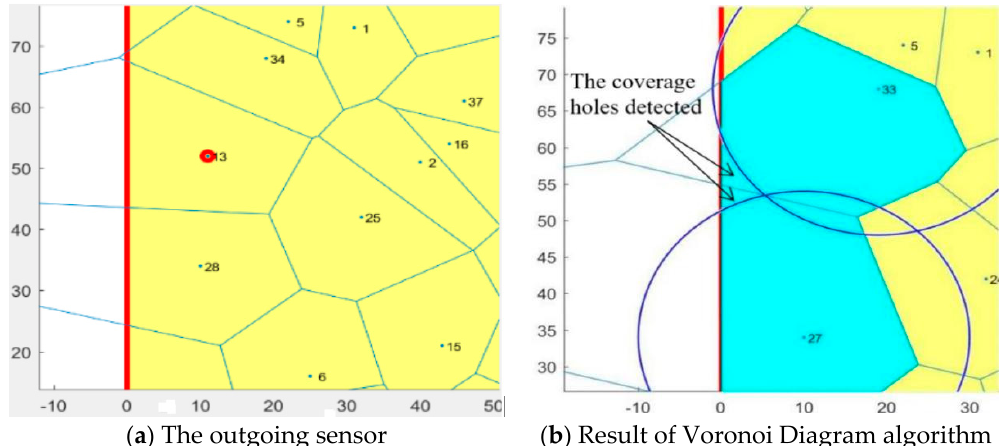
Figure 10. The coverage hole detected by the Voronoi Diagram algorithm.